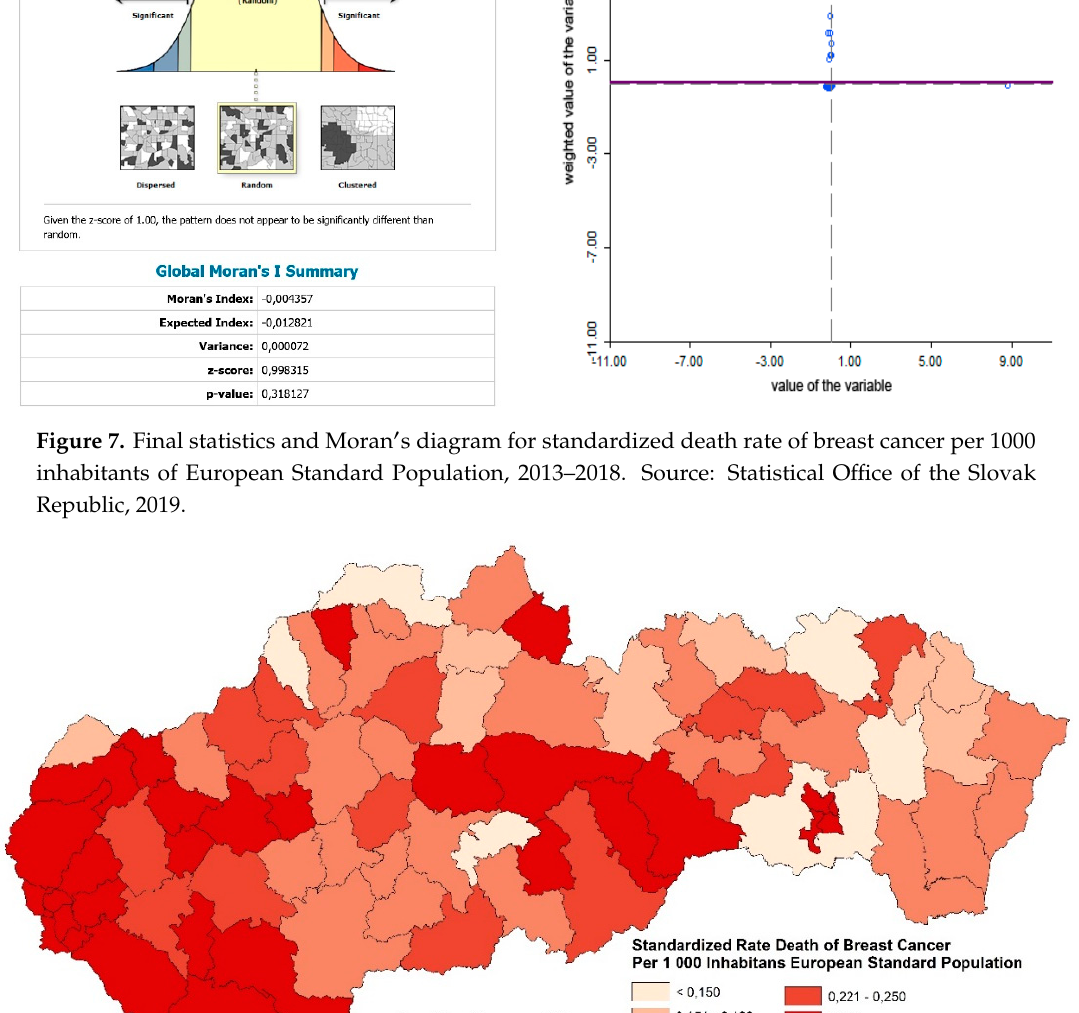
Figure 8. Standardized death rate of breast cancer per 1000 inhabitants of European Standard Population, 2001–2006. Source: Statistical Office of the Slovak Republic, 2019.